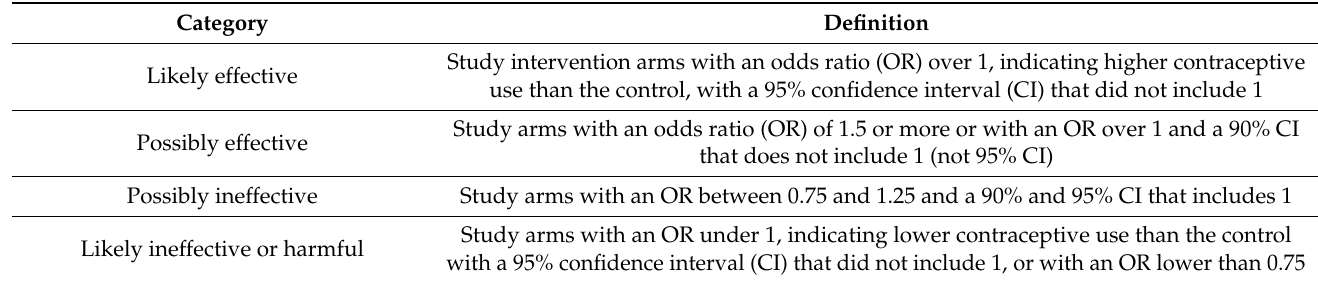
Table 1. Categories of